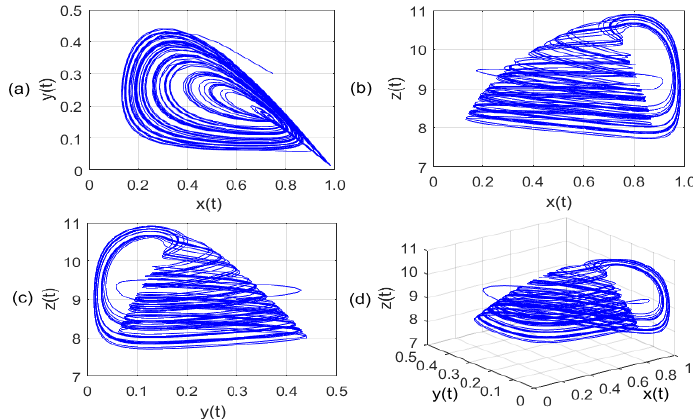
Figure 1. The chaotic attractor of system (4). (a) x ( t )- y ( t ); (b) x ( t )- z ( t ); (c) y ( t )- z ( t ); (d) x ( t )- y ( t )- z ( t ).